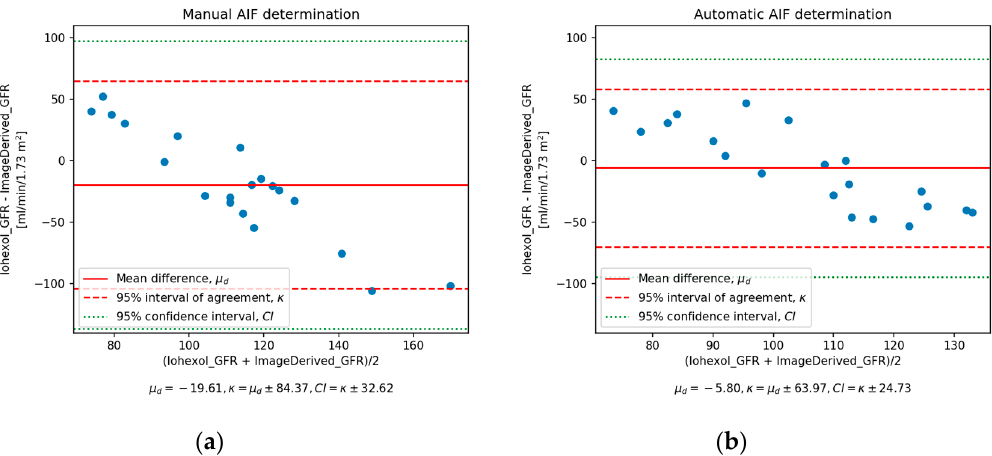
Figure 5. Bland–Altman plots of agreement for manually ( a ) and automatically ( b ) determined AIF ROIs. Measurements were evaluated against normality using Shapiro–Wilk test. The obtained p -values were equal to 0.52 (iohexol-based glomerular filtration rate (GFRs)), 0.29 (image-derived GFRs with manual ROIs) and 0.12 (for image-derived GFRs with automatically determined ROIs), thus disallowing us to reject the null hypothesis of the data with a normal distribution.